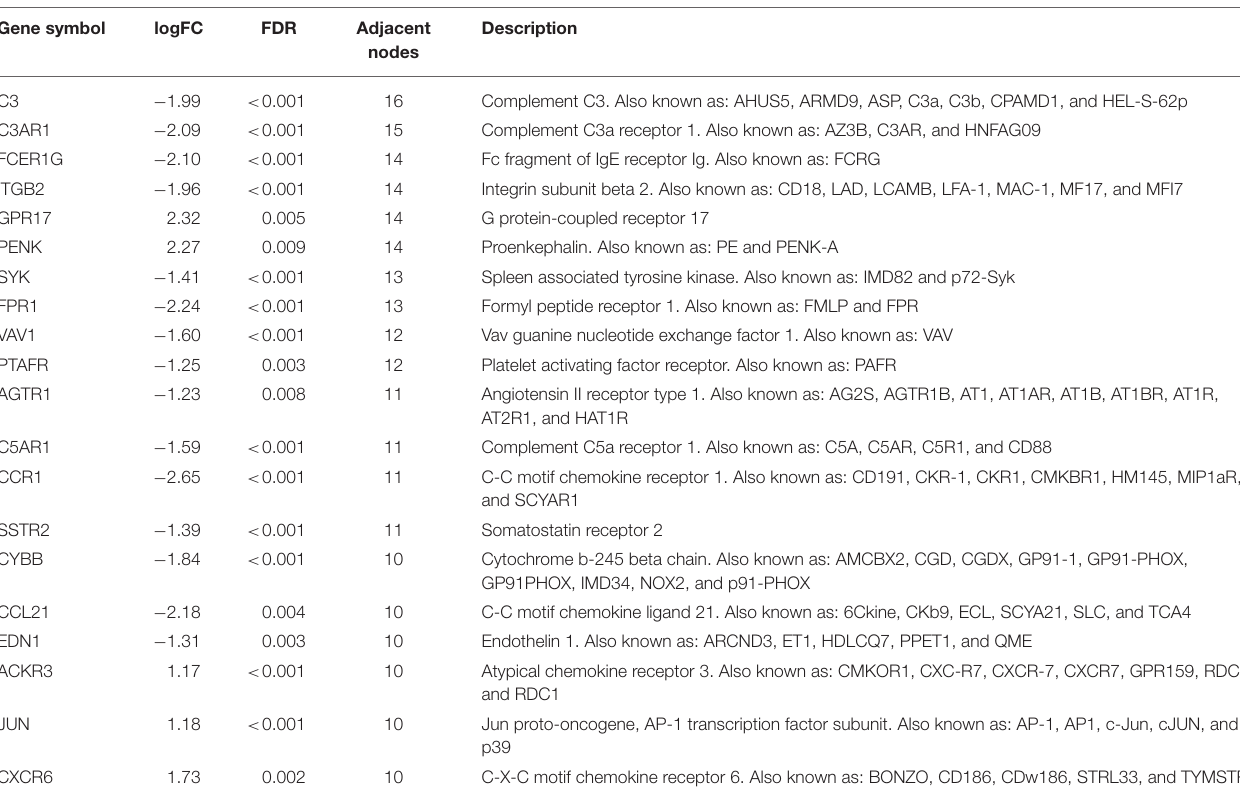
TABLE 1 | The detail information of the top-20 immune-related genes with most adjacent nodes in protein-protein interaction network.